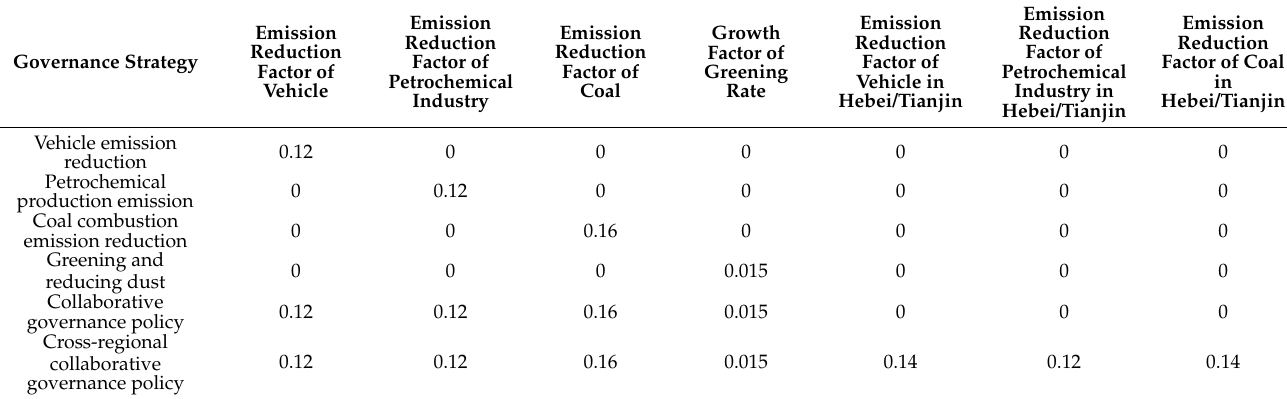
Table 3. The parameter combination of governance